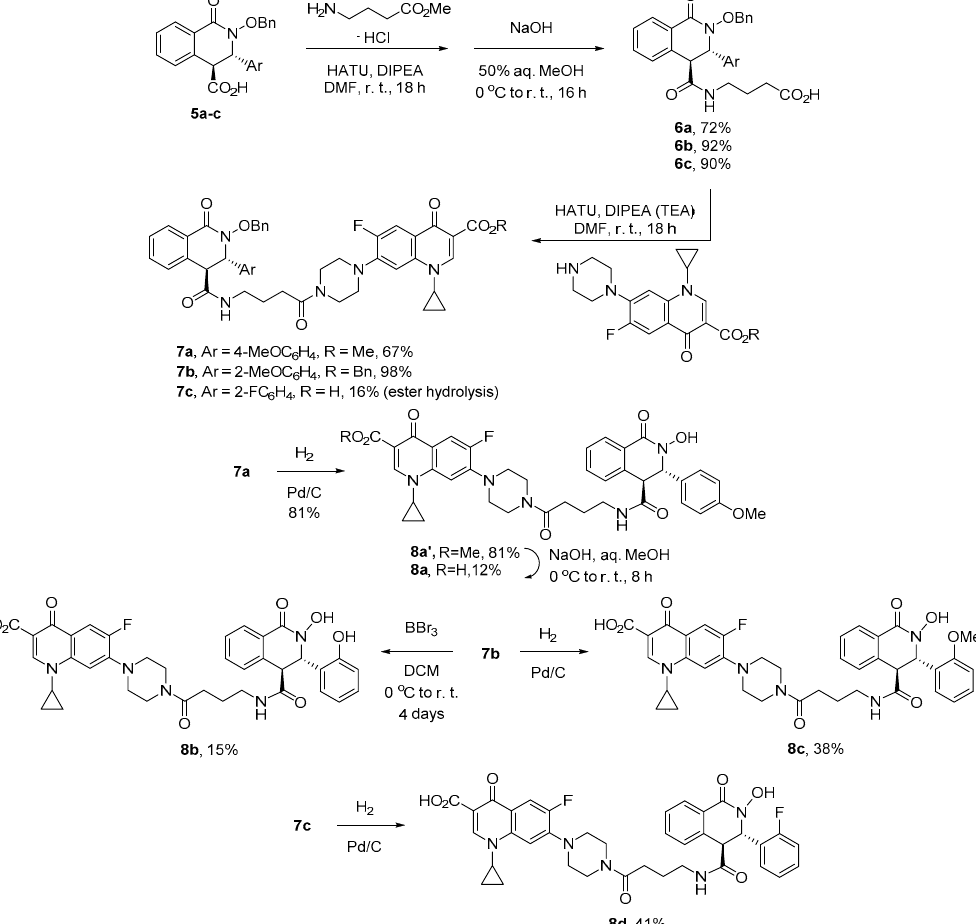
Table 1. MIC values determined for ciprofloxacin-siderophore conjugates 8a–d against P. aeruginosa PAO1 and ∆ pvdF ∆ pchA strains grown in MH or CAA (iron-restricted) medium (both strains were grown in the presence of increasing concentrations of 8a–d ; the MIC values were measured in μ M after 48 h in triplicates; ciprofloxacin was used as the positive control displaying an MIC value of 48 ± 1.2 μ